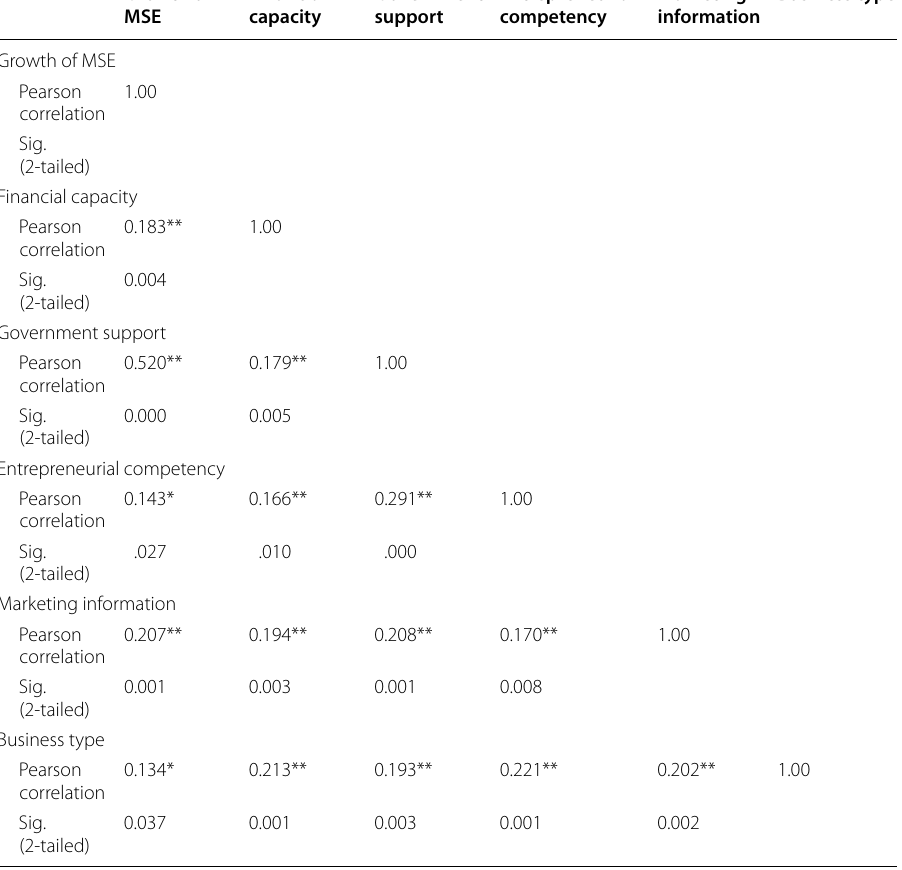
Table 4 Correlation matrix